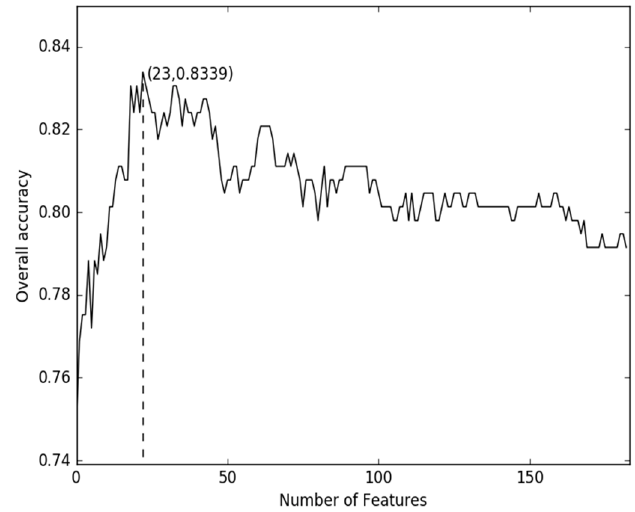
Figure 3. The incremental feature selection curve for the values of accuracy against the combination subsets.